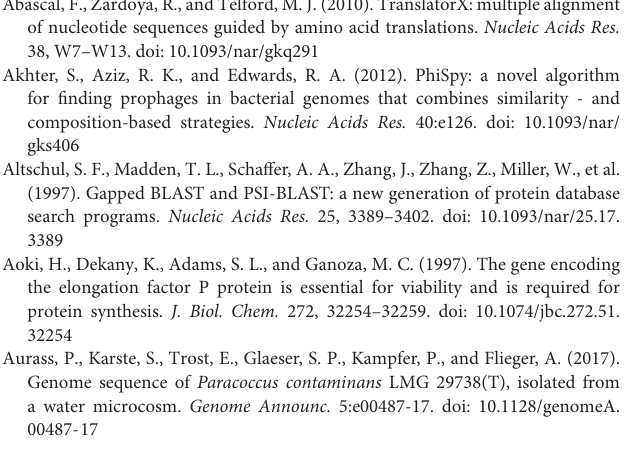
TABLE S5 | Species- and strain-specific genes of P. yeei CCUG